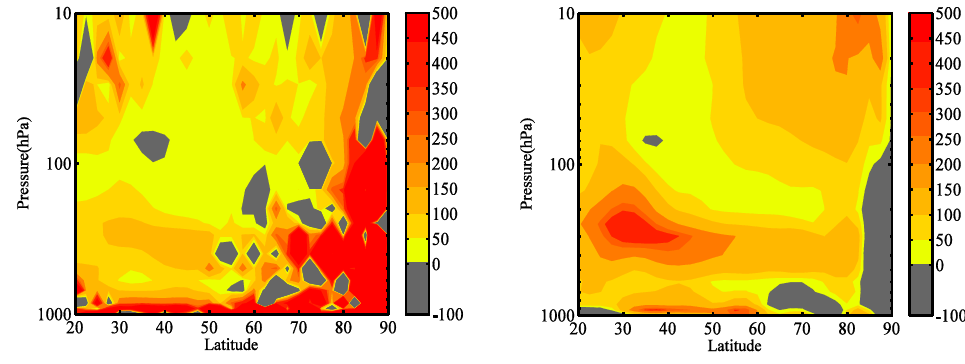
Figure 6. climatology of a 2